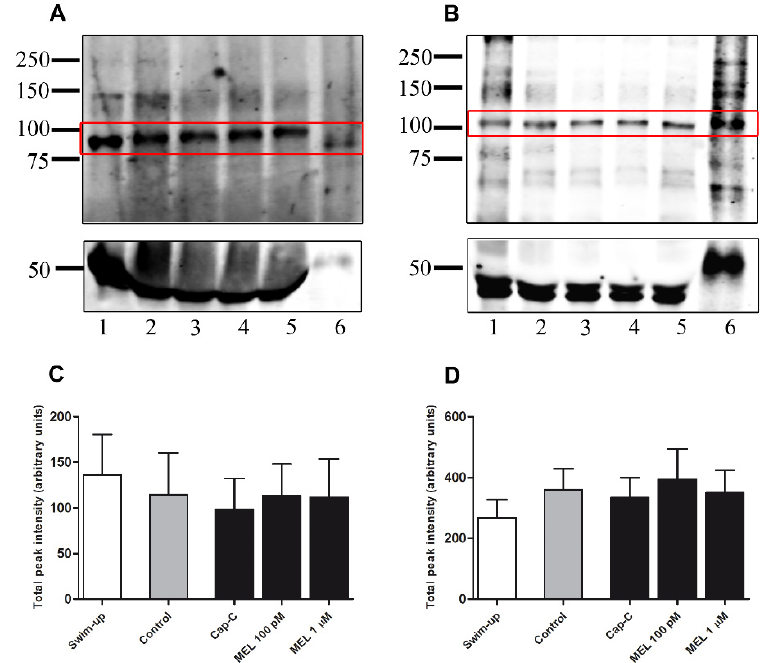
Figure 7. Western blot analysis of the presence of nitric oxide synthase isoforms eNOS ( A ) and nNOS ( B ) in swim-up selected (lane 1) and incubated 3 h in capacitating conditions without (control, lane 2) or with cAMP-elevating agents (Cap-C, lane 3) ram spermatozoa protein extracts. Effect of melatonin (MEL) 100 pM and 1 µM in capacitated samples with high cAMP (lanes 4 and 5). Positive controls: rat lung extract for eNOS (RLE, lane 6 in A) and mouse brain extract for nNOS (MBE, lane 6 in B). Densitometry quantification of eNOS ( C ) and nNOS ( D ) normalized to α -tubulin (loading control) analyzed by Western blot ( n = 4).